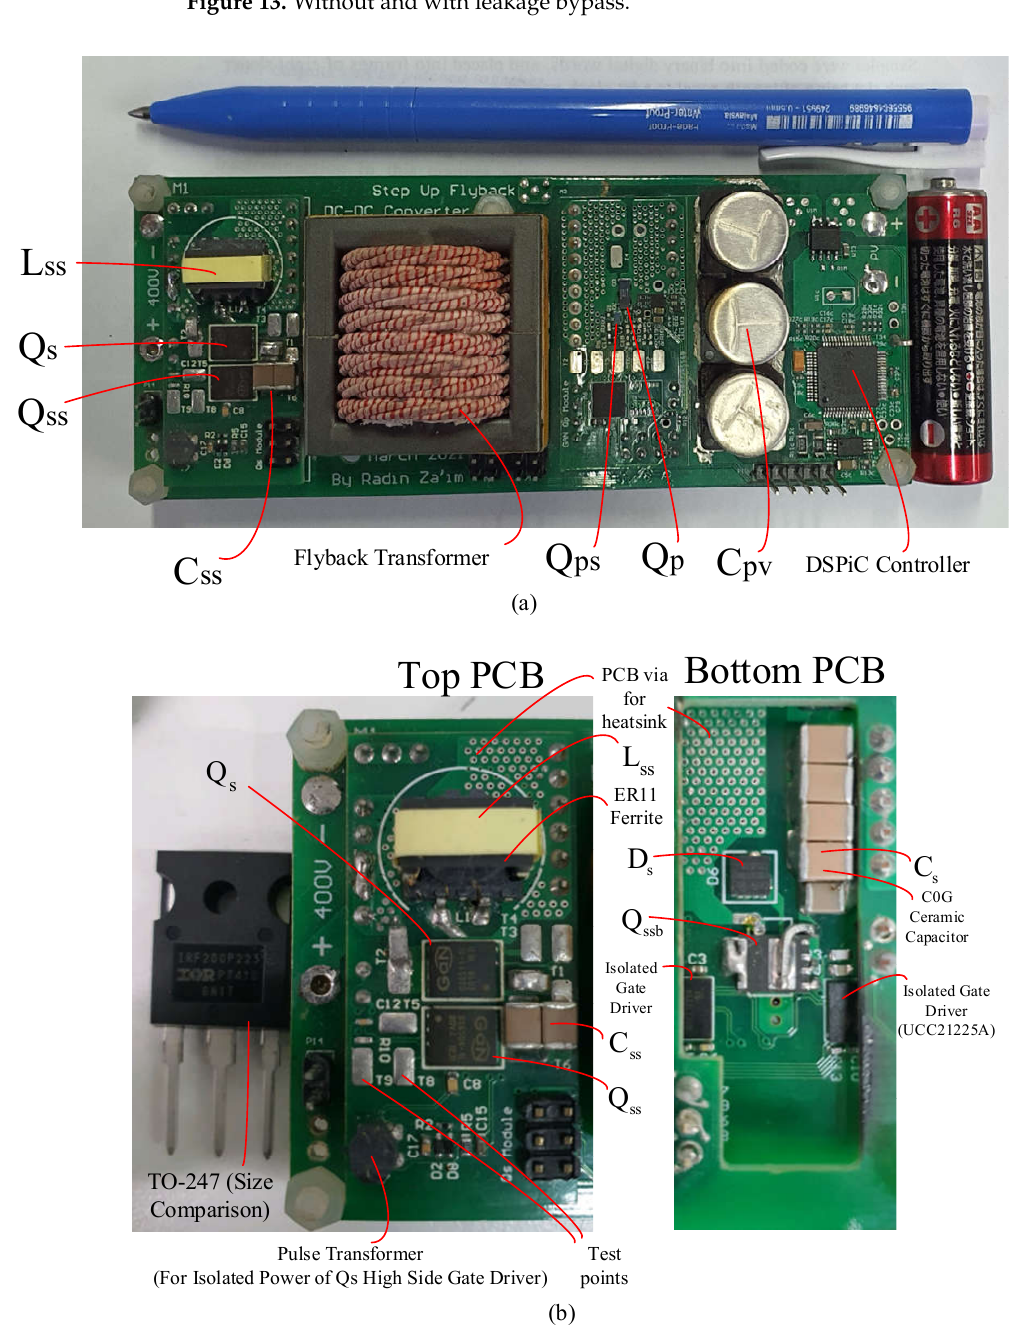
Figure 14. Developed prototype of high step-up flyback converter ( a ) the whole board ( b ) the secondary module.